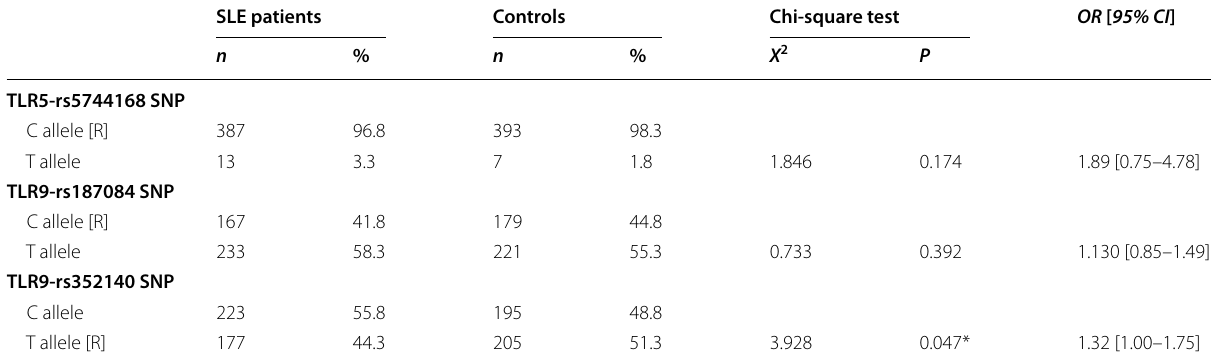
Table 1 Comparison of allele distribution of TLR9 gene SNP rs187084 and TLR5 gene SNP rs5744168 between SLE patients and